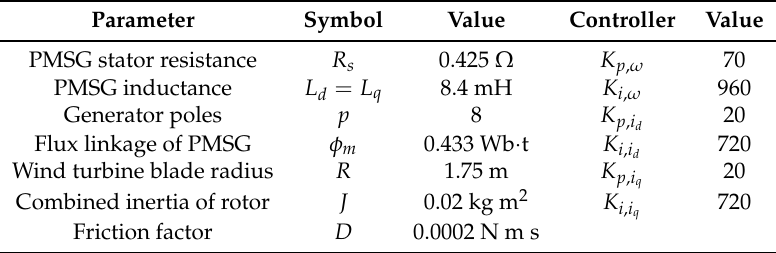
Figure 4. Mathematical block-diagram for V d and V q reference generation with current decoupling. Table 1. Parameters for